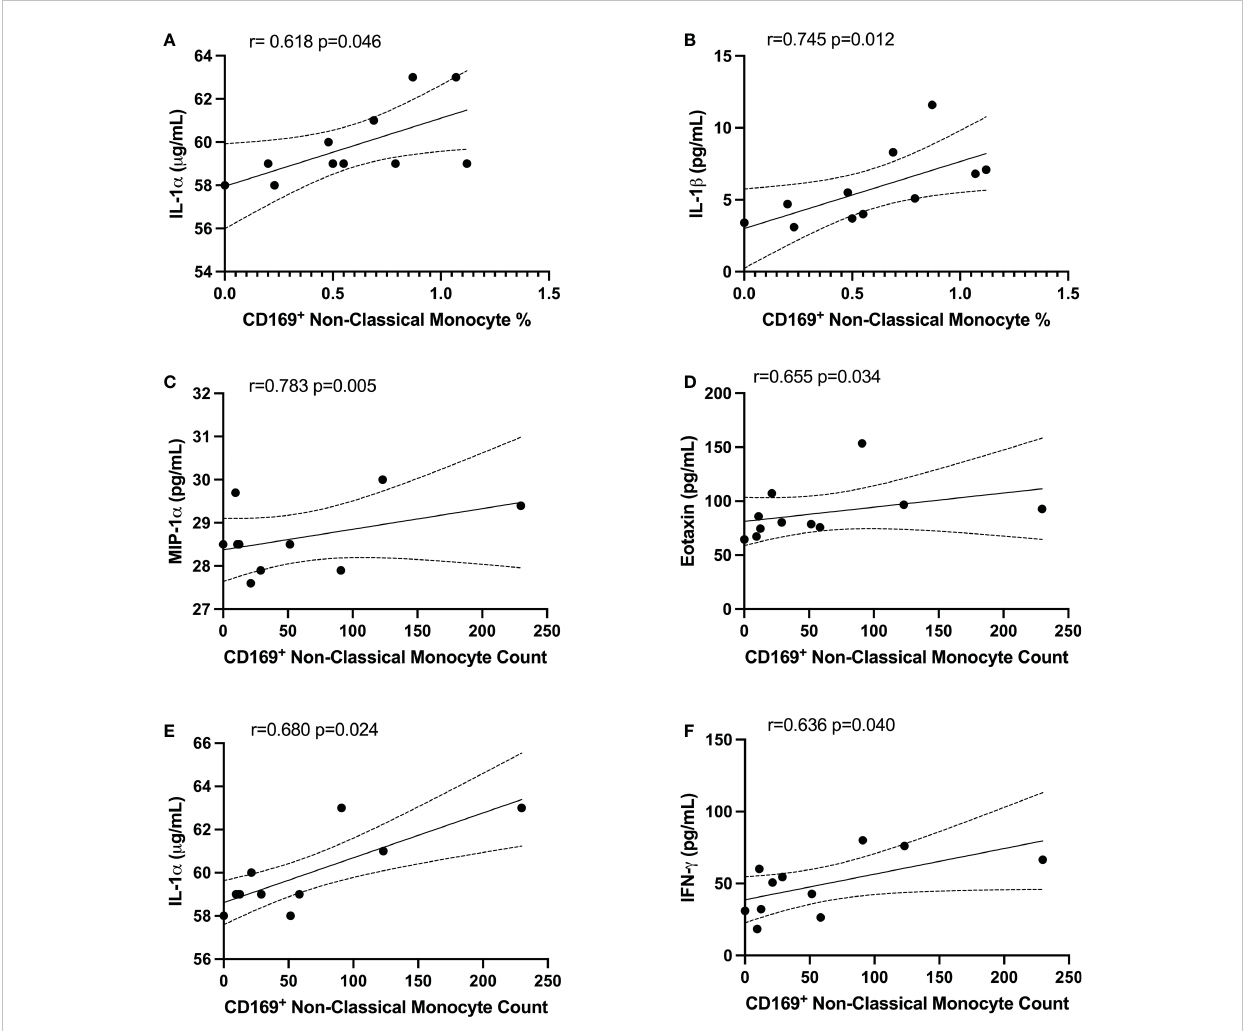
FIGURE 6 CD169 + non-classical monocytes were associated with IL-1 a , IL-1 b , MIP-1 a , Eotaxin, and IFN g in PG. Spearman correlation between the percentage of non-classical CD169 + monocytes and (A) IL-1 a and (B) IL-1 b . Spearman correlation between CD169 + non-classical monocyte count and (C) MIP- 1 a , (D) Eotaxin, (E) IL-1 a , and (F) IFN g